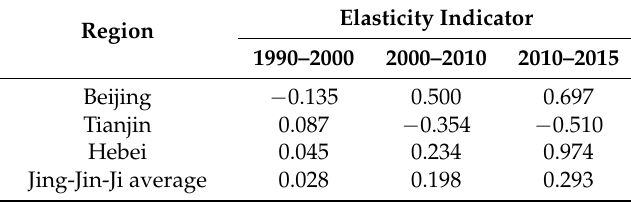
Table 3. Elasticity indicator (EI) in the Jing-Jin-Ji region.